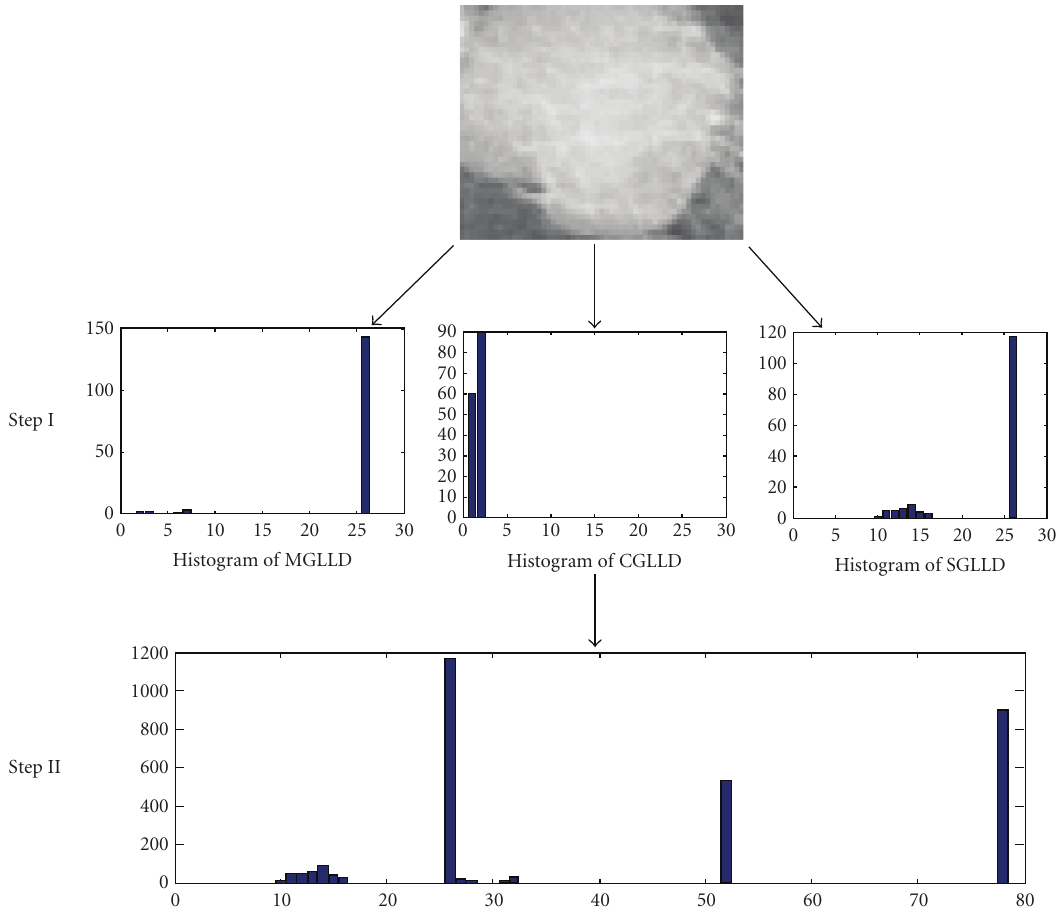
Figure 6: The extraction of the di ff erent local features from an ROI sample. Step (I): the texture features can be computed by building the histogram over the corresponding ROI. Step (II): the histogram from the three operators is concatenated to build the texture features of the selected